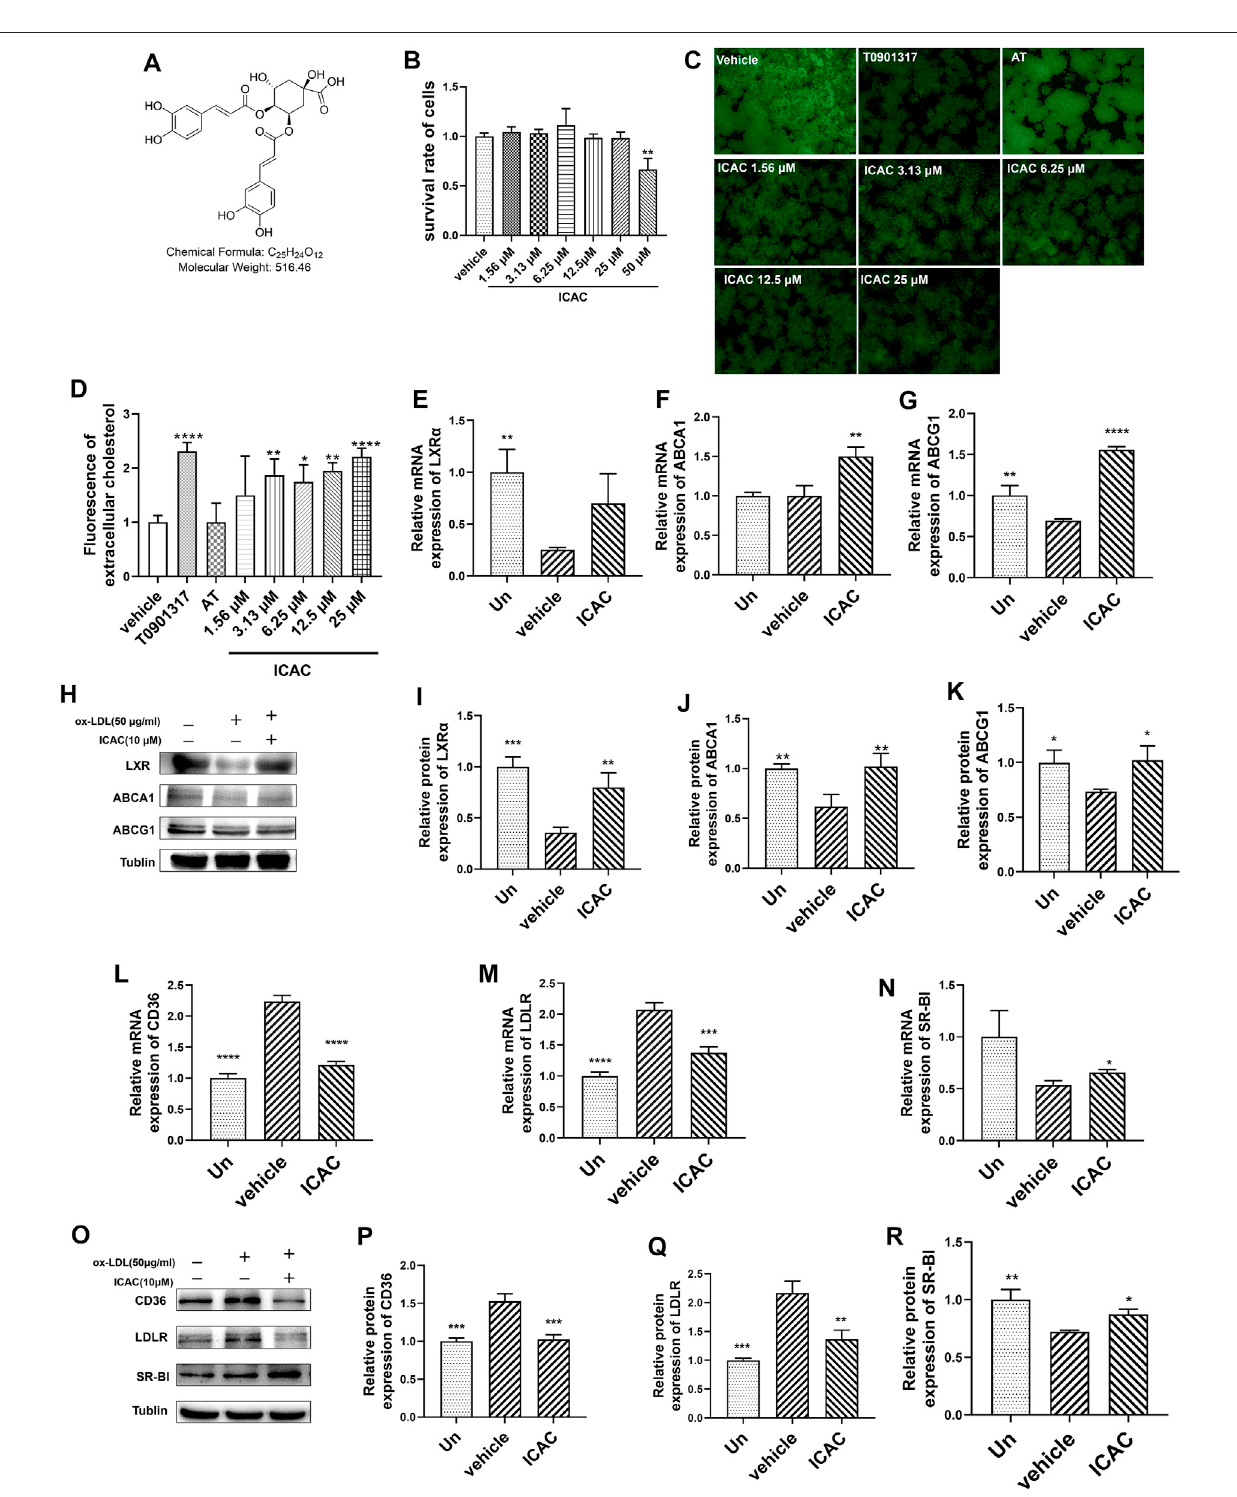
FIGURE 1 | ICAC triggers the reverse cholesterol transport pathway and promotes cholesterol ef fl ux. (A) Chemical structure of isochlorogenic acid C (ICAC). (B) Cell survival rate assay of ICAC in BMMs. (C) Fluorescence in BMMs under light microscopy. (D) Extracellular fl uorescent cholesterol intensity was measured with a microplate reader. (E – G) Gene expression level of LXR α , ABCA1 and ABCG1 in BMMs. (H – K) Protein expression level of LXR α , ABCA1, and ABCG1 in BMMs. (L – N) Gene expression level of CD36, LDLR, and SR-BI in BMMs. (O – R) Protein expression level of CD36, LDLR, and SR-BI in macrophages. All data in (B,D – G,I – N,P – R) were represented as mean ± SEM. Statistical difference was determined by one -way ANOVA test. Compare with a vehicle, * p < 0.05, ** p < 0.01, *** p < 0.001, **** p < 0.0001. n = 3 for each group.